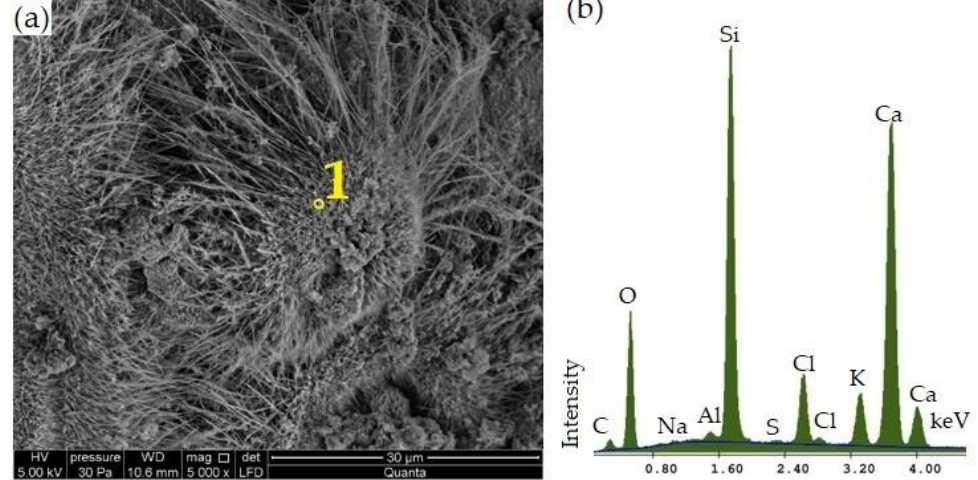
Figure 9. Microscopic SEM image of calcium – silica samples with 100% CBPD at ( a ) 5000× magnifi- cation and micro-X-ray analysis of its elemental composition in Point ( b ) 1. tion and micro-X-ray analysis of its elemental composition in Point ( b )